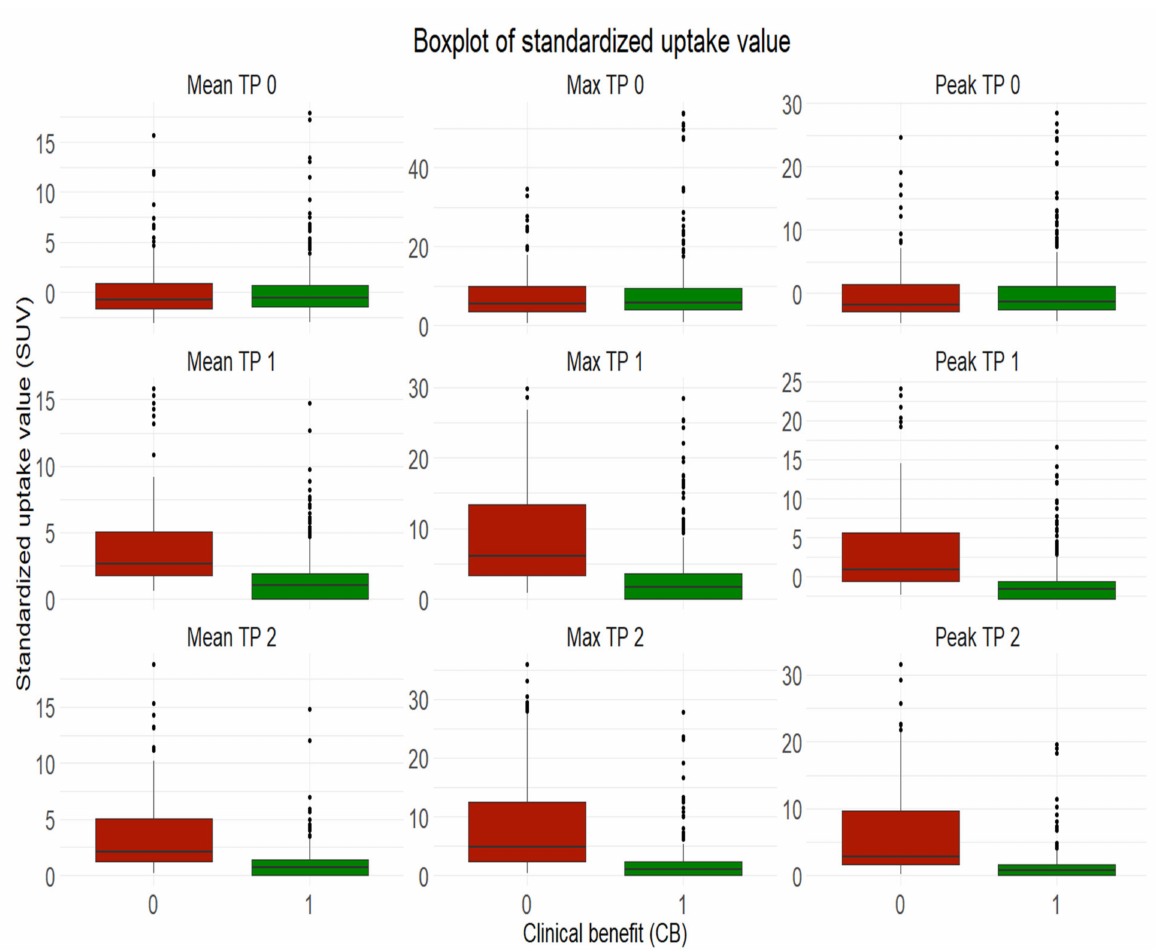
Figure 3. Boxplot of standardized uptake value per time point SUVmean (first column from left), SUVmax (column in the middle) and SUVpeak (first column from right). In green non progressive melanoma metastasis with clinical benefit six months after treatment. In red progressive melanoma metastasis six months after treatment. First raw from the top: at baseline TP 0. Second raw: three months after initiation of immunotherapy TP 1. First raw from the bottom: six months after initiation of immunotherapy TP